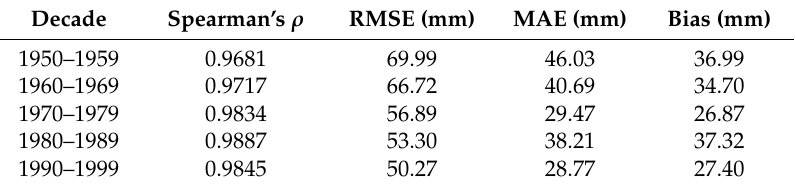
Table 1. Comparison of cumulative October–March SFE from Climatic Research Unit (CRU) TS 3.0 and